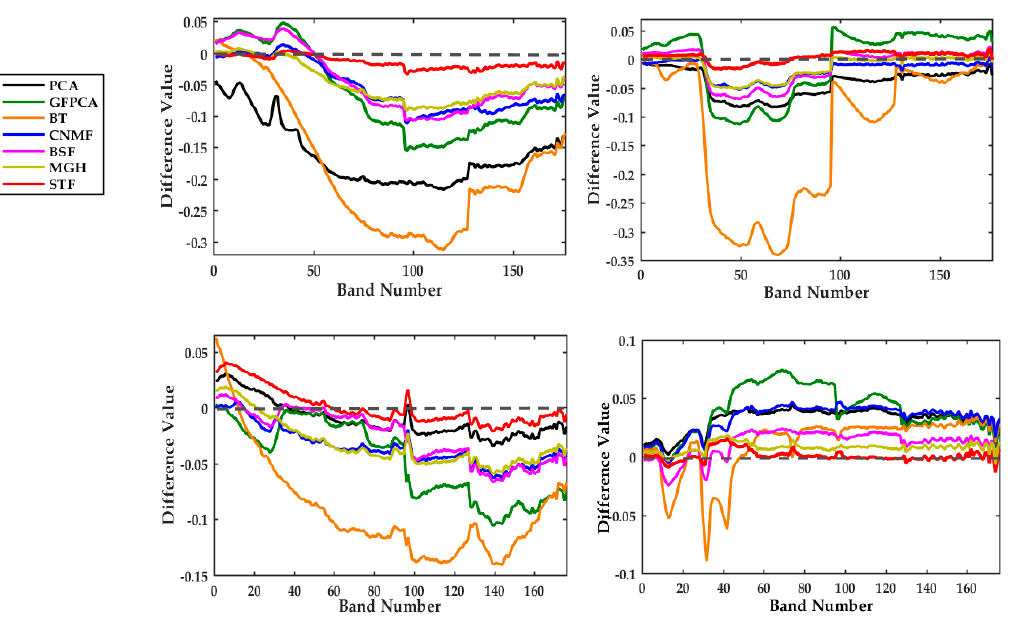
Figure 8. Spectral reflectance difference values comparison on four single pixels shown in Figure 7a.